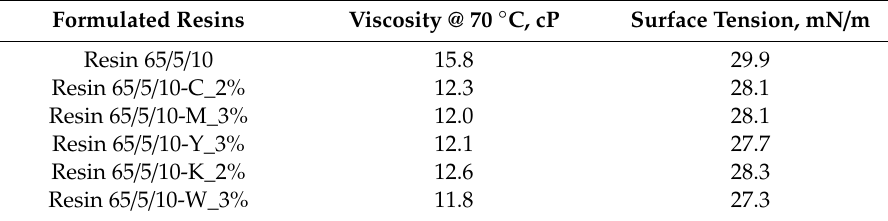
Table 2. Viscosity and surface tension of the formulated resins ready for inkjet printing. Formulated